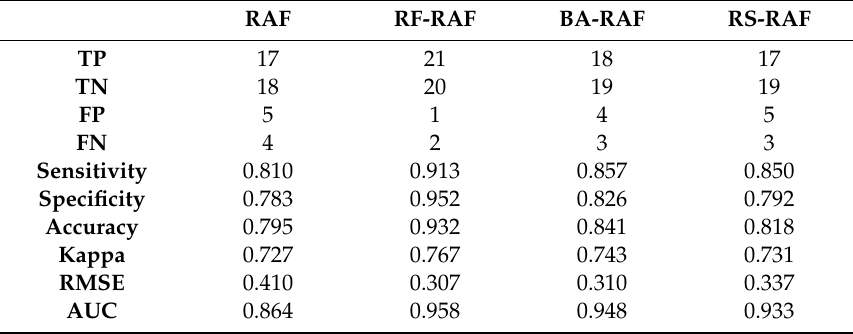
Table 4. Model performance (prediction accuracy) for the validation